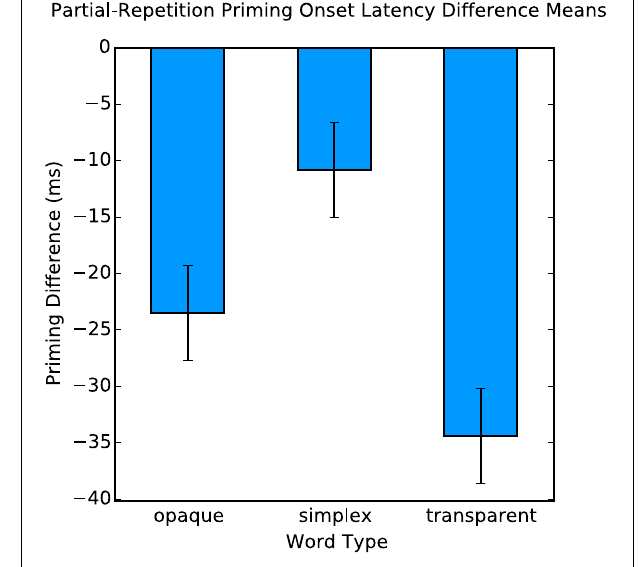
FIGURE 2 | Partial-repetition priming onset latency difference